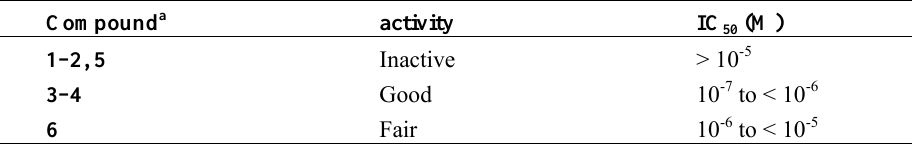
Table 2. Antimalarial activity of compounds 1 – 6 against P.